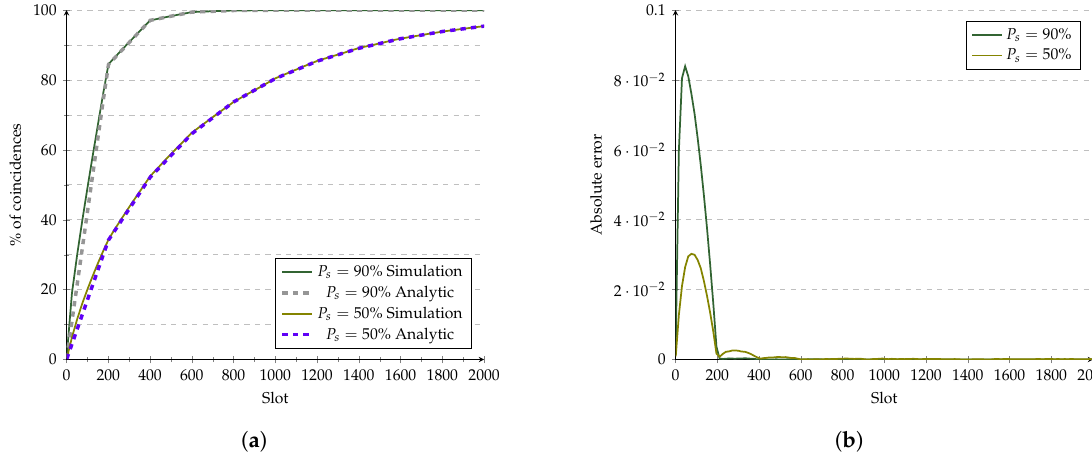
Figure 14. Evaluation of Searchlight’s analytic model at 10% duty cycle. ( a ) Analytic model vs. simulations. ( b ) Error of the analytic model.